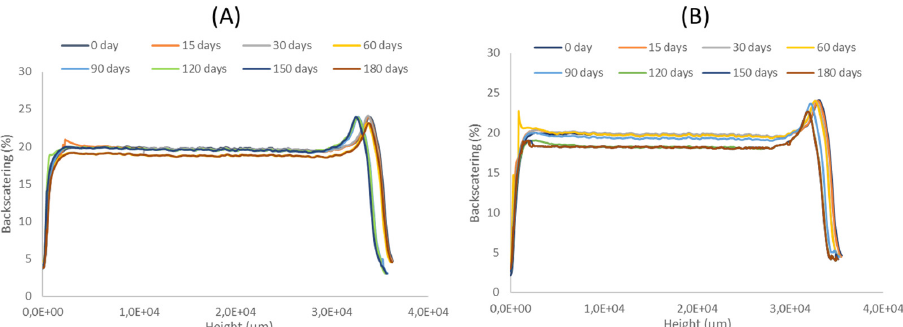
Figure 9. Backscattering profiles of colloidal suspensions at 4 ◦ C. ( A ) PGZ-NPs and ( B ) Spray 2 formulation.